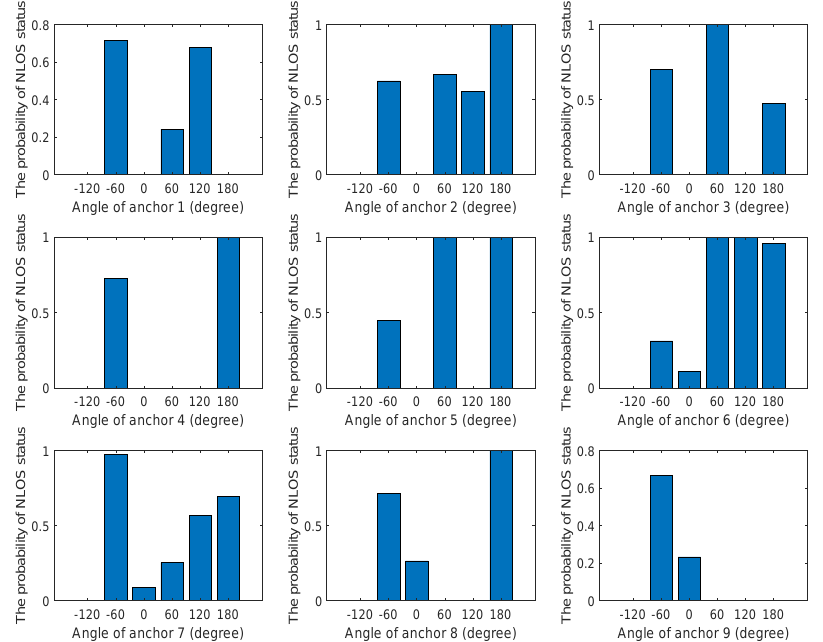
Figure 8. The relationship between angle and NLOS status probability. The horizontal axis of each graph represents angle (degree) and the vertical axes represent NLOS status